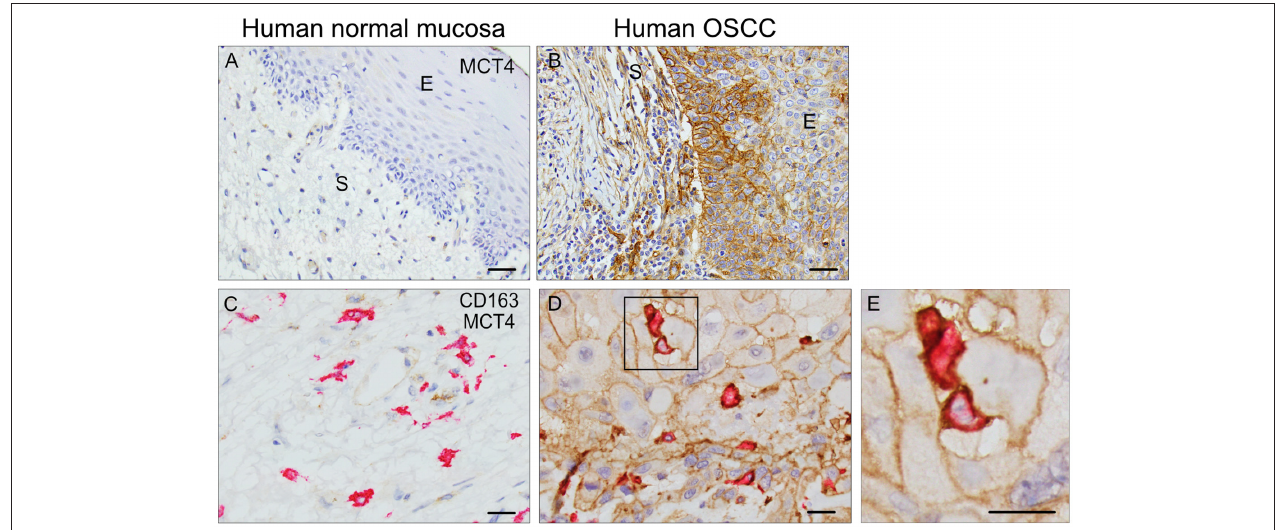
FIGURE 1 | MCT4 is expressed in Human OSCC: Single MCT4 (A,B) and dual MCT4/CD163 (C–E) immunostaining in paraffin embedded samples of human OSCC. Area of adjacent normal epithelium in OSCC sample #1 (A) , area of squamous cell carcinoma within the same sample #1 (B) . MCT4 negative/CD163 positive macrophages in adjacent normal area of oral mucosa in sample #2 (C) . MCT4 positive/CD163 positive macrophages in areas of cancer cells within same sample #2 (D) . Boxed region in D is showed at higher magnification in E (2.5X). Scale bar: 20 µ m. S, stroma; E,